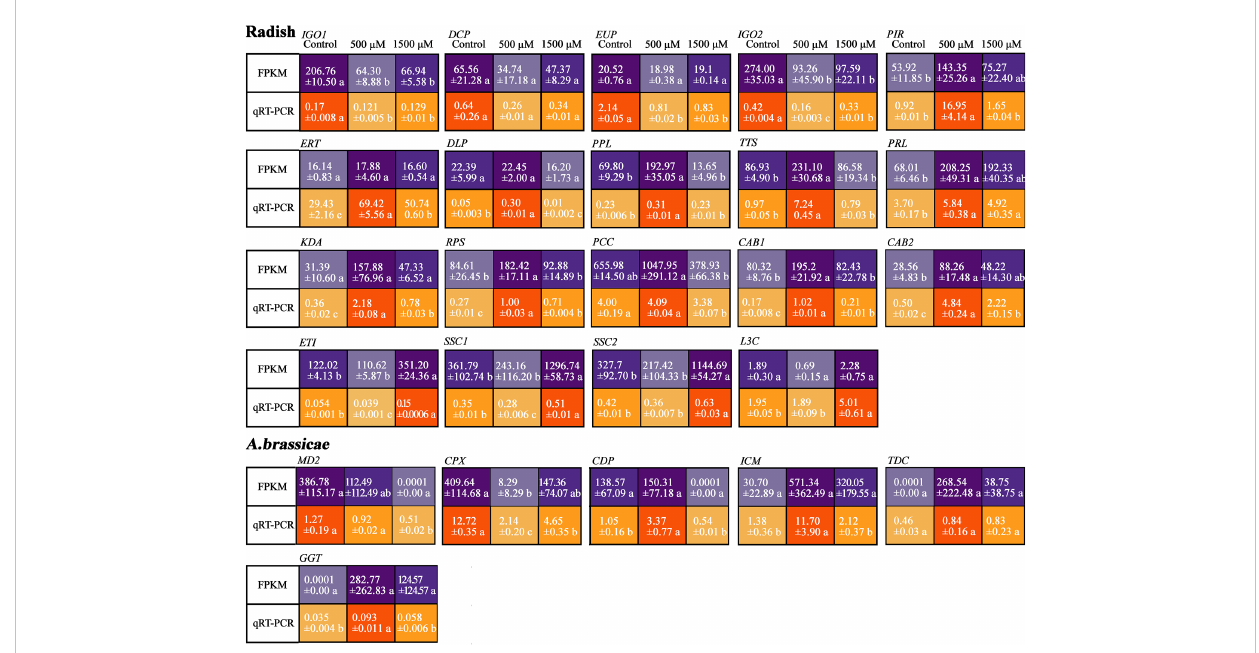
FIGURE 7 Veri fi cation of selected DEGs of “ JNYB ” radish and A. brassicae from dual RNA-seq using qRT-PCR. The relative expression level of a gene in was determined using a 2 - △△ Ct method, and signi fi cant difference at P < 0.05 compared with the control is indicated by lowercase